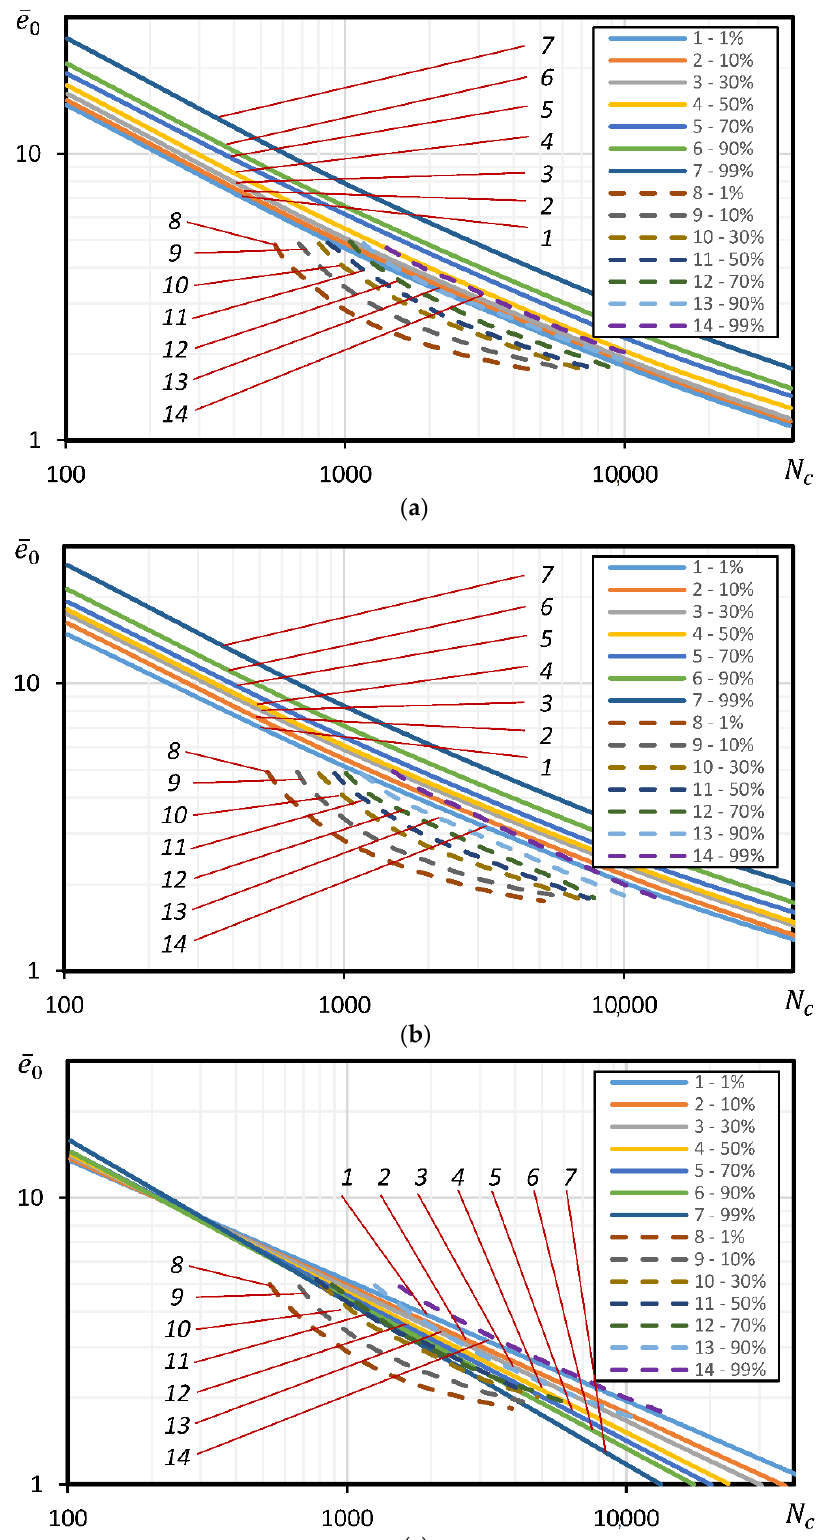
Figure 9. Experimental (dashed lines) and theoretical (straight lines) curves for 15Cr2MoVa steel under loading with controlled strain (1–7 = analytical probability, 1–99%; 8–14 = experimental probability, 1–99%): ( a ) according to Coffin dependency (Equation (11)); ( b ) according to Manson– Langer dependency (Equation (13)); ( c ) according to PNAE rules (Equation (14)). The comparison of the experimental and theoretical curves of steel C45 under loading with controlled strain ( e k = constant) in Figure 10a suggests that, in all cases, the resulting curve slope was similar. The theoretically calculated curves were lower than the experi- mental ones; however, in this case, the probability arrangement of the curves was not the reverse. The 99% to 1% durability curve ratio is 7.1:1 at the relative strain amplitude 𝑒 0 ̅ = 4% calculated by Equation (11), 7.6:1 according to Equation (12), and 10.3:1 according to Equation (12). In this case, with the relative strain amplitude 𝑒 0 ̅ = 2%, the ratios of the durability curves were 8.4:1, 11.7:1, and 5.3:1. Figure 10c suggests that the calculation un- der the PNAE rules, Equation (15), had the best correspondence with the experimental results. The results for the D16T1 aluminium alloy under loading with controlled strain ( e k = constant) are presented in Figure 11. A comparison of the 99% and 1% probability curves in Figure 11a showed the clear dependence of the low-cycle durability on the strain level. The conducted analysis suggested that the 99% to 1% durability curve ratio was 37:1, where the strain amplitude e 0 = 0.3%, and 24:1 where the strain amplitude e 0 = 0.18%. The